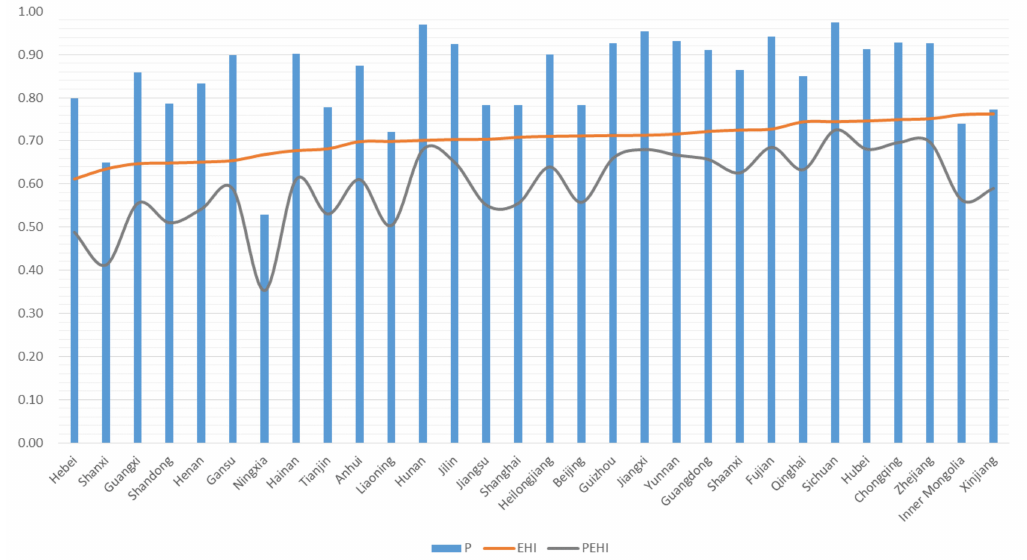
Figure 6. P, EHI, and PEHI of 30 provinces,